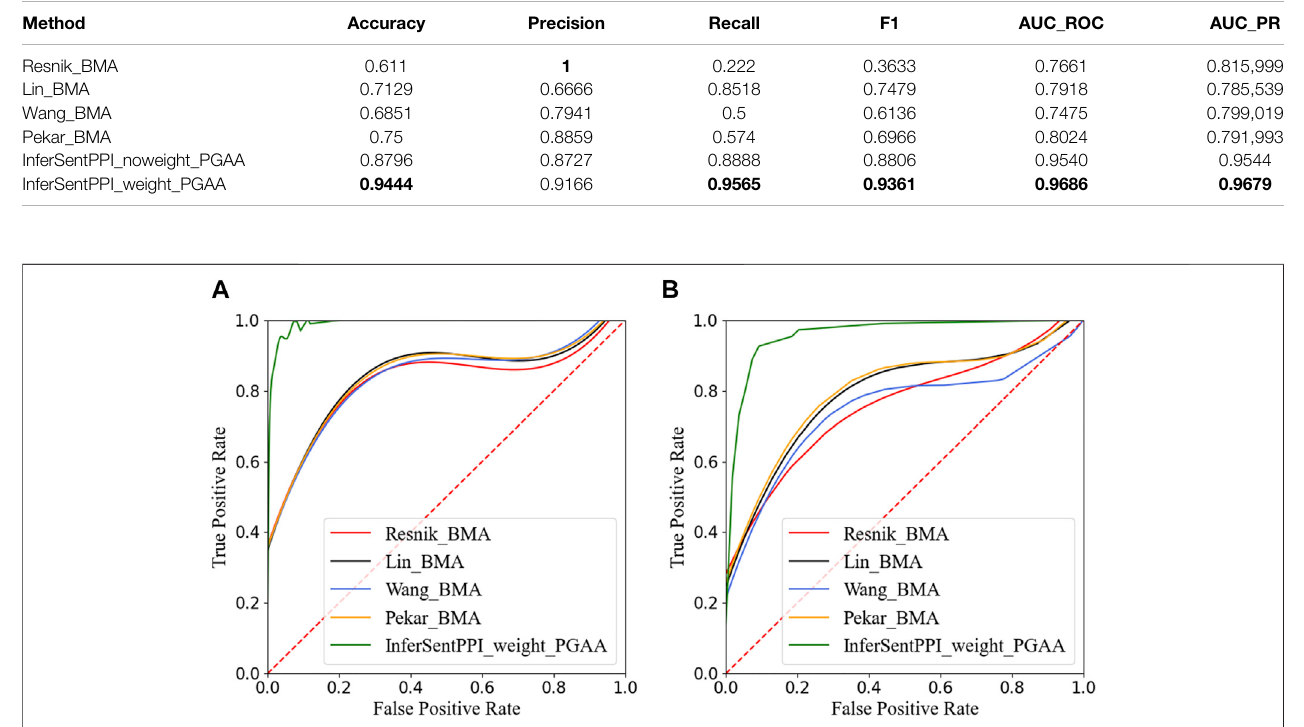
TABLE 3 | Performance comparison of six methods on the human dataset from HPRD. Method